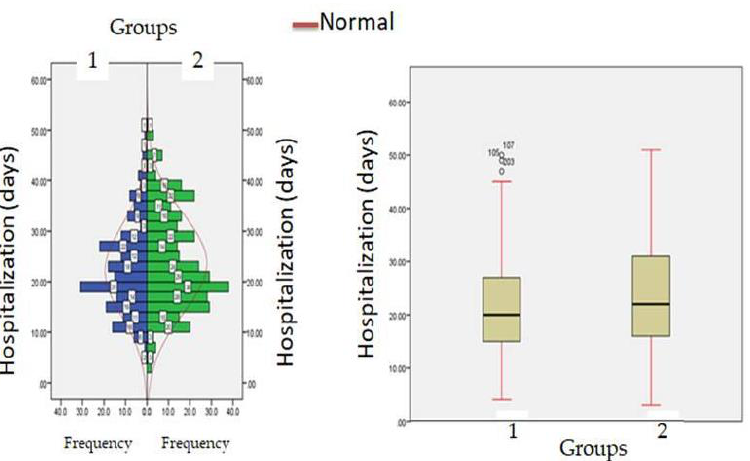
Figure 7. Hospitalization (days) in patients with normocreatinemia (Group-I) and hypercreatinemia (Group-2). Table 3. Clinical outcomes of study population according to creatinine levels.